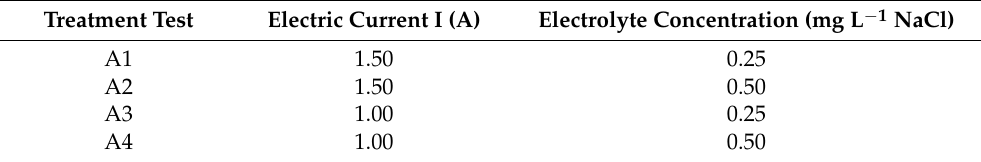
Table 1. Values of the tested combinations of the electrochemical parameters electric current (I) and electrolyte (NaCl) concentration selected to optimize the procedure of electroflotation to treat wastew- ater contaminated with the herbicide chlorimuron-ethyl (at a nominal concentration of 1 mg L − 1 ). Treatment Test Electric Current I